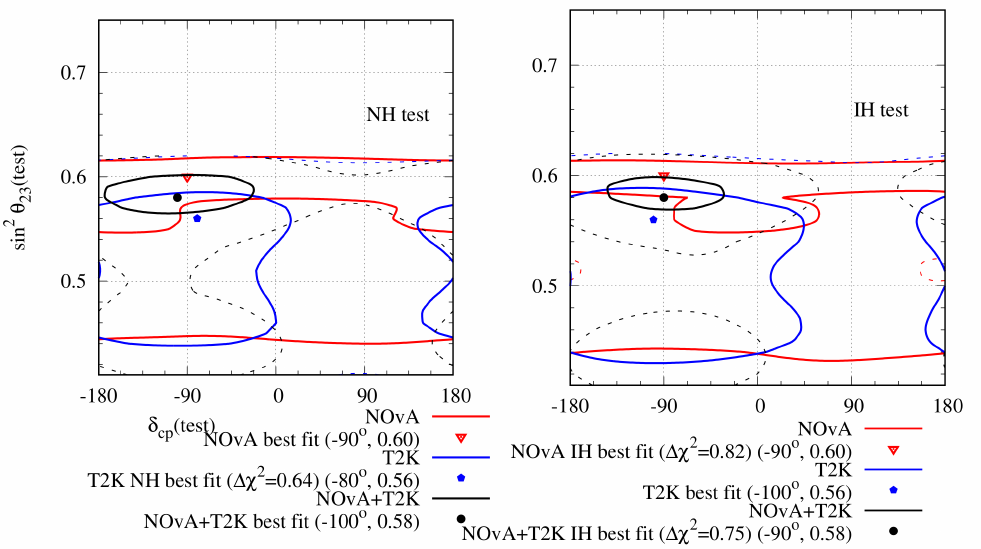
Figure 13. Allowed region in the sin 2 θ 23 − δ CP plane after analysing NO ν A and T2K complete data set with NSI hypothesis. Only the effect of (cid:101) e µ = | (cid:101) e µ | e i φ NSI e µ has been considered. The left ( right ) panel represents test hierarchy to be NH (IH). The red (blue) lines indicate the results for NO ν A (T2K) and the black line indicates the combined analysis of both. The solid (dashed) lines indicate the 1 σ (3 σ )-allowed regions. The minimum χ 2 for NO ν A (T2K) with 50 (88) bins is 49.08 (93.64) and it occurs at NH. For the combined analysis, the minimum χ 2 with 138 bins is 146.26.